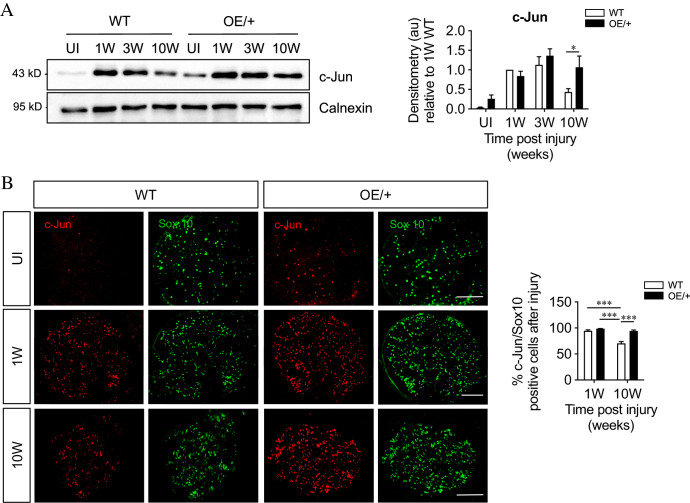
c-Jun expression is maintained in c-Jun OE/+ Schwann cells during chronic denervation.(A) Representative western blots of c-Jun in WT and c-Jun OE/+ distal stumps after 1, 3, and 10 weeks of denervation. The results are quantitated in the graph. In contrast to WT nerves, c-Jun OE/+ nerves maintain consistent levels of c-Jun during 10-week chronic denervation. Data normalized to WT 1 week post-injury. Two-way ANOVA with Sidak’s multiple comparisons test; *p<0.05. n = 5. (B) Representative images showing c-Jun/Sox10 double immunofluorescence in transverse sections of WT and OE/+ uninjured and injured distal stumps. The graph shows quantitation by cell counting. The c-Jun labeling of Sox10-positive nuclei in the two genotypes is comparable at 1 week, but reduced at 10 weeks in WT nerves only. Two-way ANOVA with Tukey’s multiple comparison test; ***p<0.001. n = 3. All numerical data represented as means ± SEM, all scale bars: 100 µm.